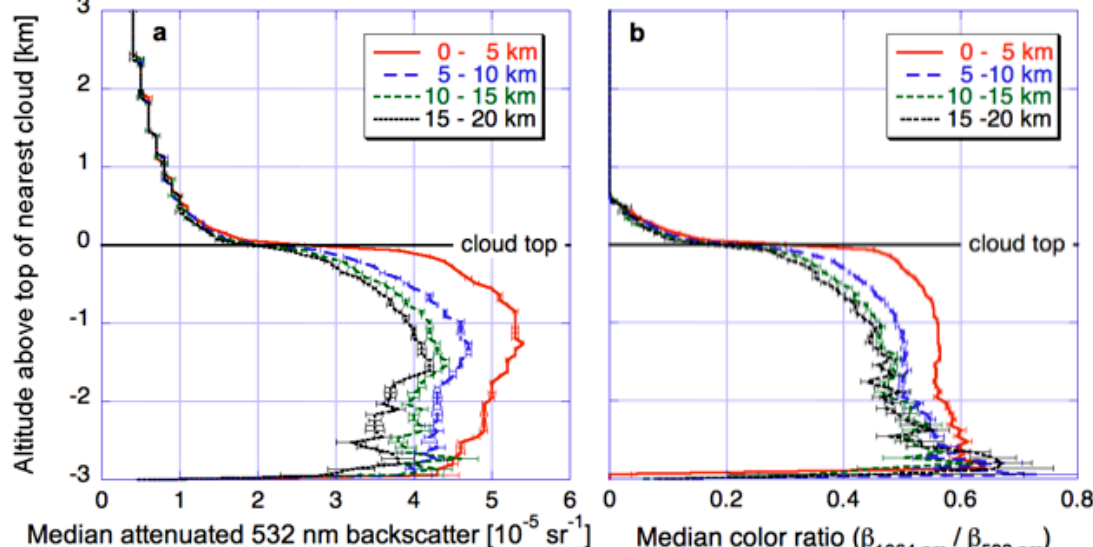
Figure 4. ( a ) Median 532-nm attenuated backscatter ( β 532 ) as a function of altitude above the top of the nearest cloud, plotted separately for different distance-ranges from the nearest cloud. ( b ) Same, but showing median color ratio values (related to particle size). Both panels display data from a global dataset of oceanic clear-sky columns where the nearest cloud is below 3 km. The figure is based on Figure 3 of [27].